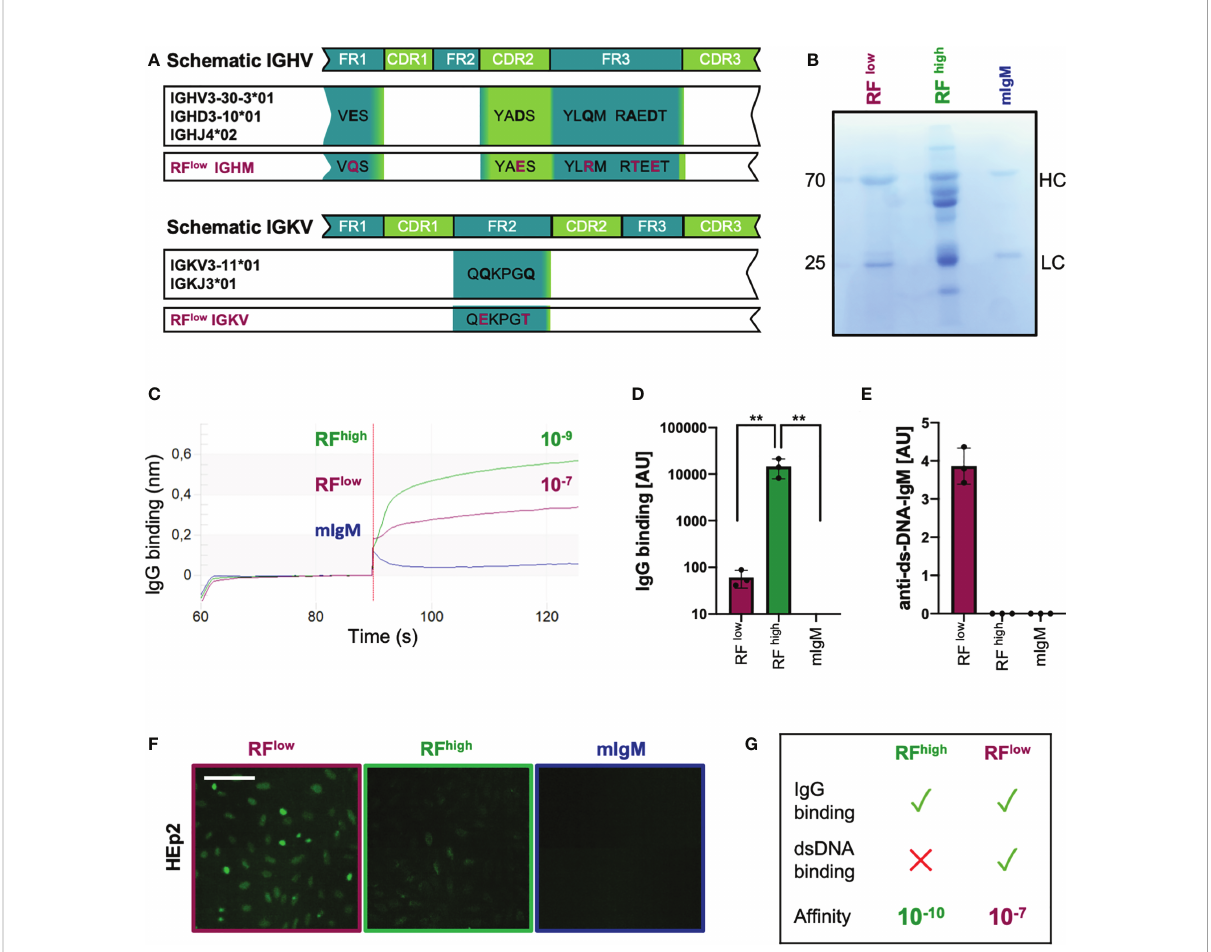
FIGURE 3 Recombinant low-af fi nity RF is polyreactive and binds DNA. (A) Schematic representation of the immunoglobulin heavy and light variable genes (IGHV and IGLV, respectively) of the recombinant puri fi ed low-af fi nity RF as compared to the closest germline respective alleles. Mutations are highlighted in purple. IGHM, immunoglobulin heavy constant mu; IGVK, immunoglobulin variable kappa. (B) Coomassie blue-stained SDS-PAGE showing recombinant monoclonal (in-house puri fi ed) low af fi nity RF (RF low ), commercial RF from Rheumatoid Arthritis patients (RF high ) and monoclonal control IgM (mIgM) under reducing conditions (with b -mercaptoethanol). The image is representative of three independent experiments. (C) IgG-binding af fi nity of RF low (purple line), RF high (green line) and monoclonal IgM (blue line) measured by bio-layer interferometry. K D (dissociation constant) was calculated by the software. The experiment shown is representative of 3 independent experiments. (D) Anti-IgG IgM concentrations detected in puri fi ed RF low (purple bar, n = 3), RF high (green bar, n = 3) and mIgM control (blue bar, n=3) measured by ELISA (coating: human IgG). Mean ± SD, statistical signi fi cance was calculated using ordinary one-way ANOVA with Tukey ’ s multiple comparisons test. **p < 0,01. (E) Anti-dsDNA-IgM concentrations of RF low (purple bar, n = 3), RF high (green bar, n = 3) and IgM control (blue bar, n = 3) measured by ELISA (coating: calf-thymus dsDNA). Mean ± SD. Results are representative of three independent measurements. (F) HEp-2 slides showing anti-nuclear structure-reactive IgM (ANA). Purple square: RF low ; green: RF high ; blue: mIgM control, respectively. Scale bar 65 µm. Green fl uorescence indicates IgM binding to HEp-2 cells. Images are representative of three independent experiments. (G) Schematic summary of the characteristics of RF high and RF low